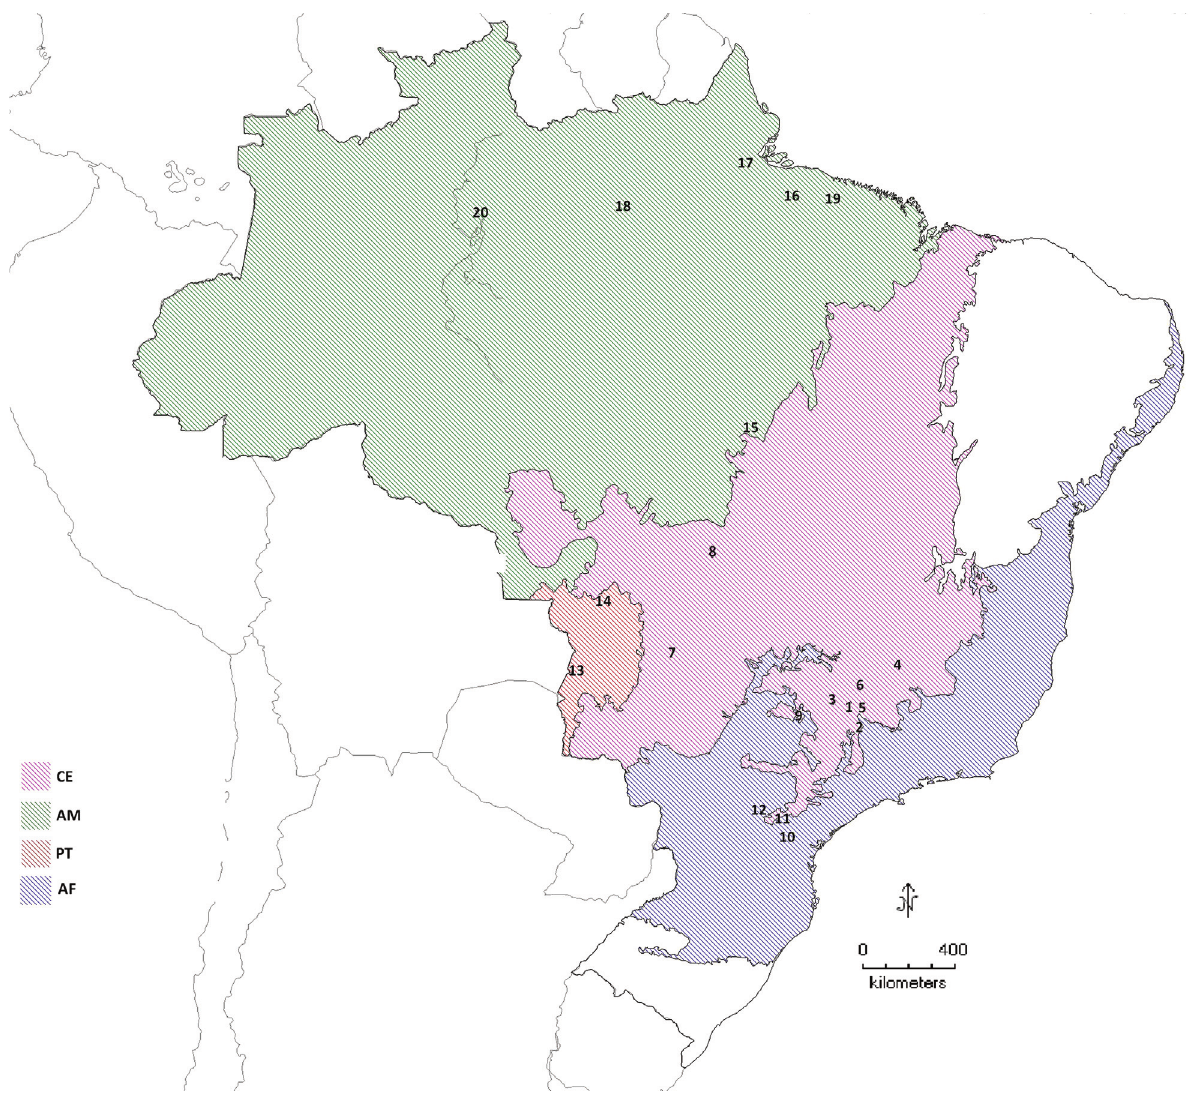
Figure 1 - Map with localities of M. tridactyla individuals sampled for this study. 1- National Park of Serra da Canastra, MG; 2- Piumhi, MG; 3- Araxá, MG; 4- Dores do Indaiá, MG; 5- Doresópolis, MG; 6- Uberlândia, MG; 7- National Park of Emas, GO; 8- Nova Xavantina, MT; 9- São José do Rio Preto, SP; 10- Jaguariaíva, PR; 11- Telêmaco Borba; 12- Piraí do Sul; 13- Corumbá, MS; 14- Poconé, MT; 15- Vila Rica, PA; 16- Ilha do Marajó, PA; 17- Mazagão, AP; 18- Oriximiná, PA; 19- Belém, PA; 20- Caracaraí,